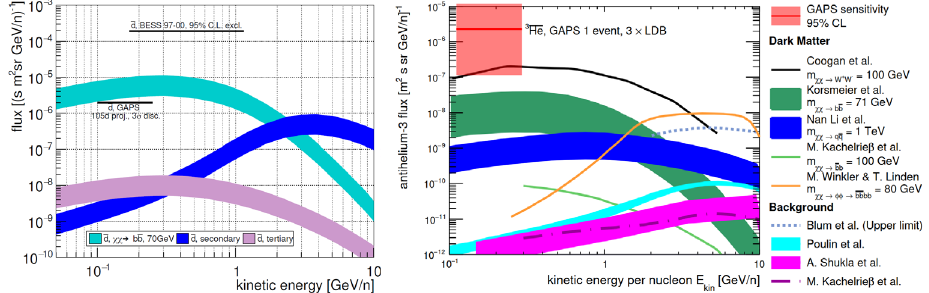
Figure 2. Left panel : the predicted antideuteron flux from a generic 70-GeV WIMP annihilating via b ¯ b -pairs (cyan), as well as the predicted secondary (blue) and tertiary (pink) astrophysical antideuteron flux. The anticipated sensitivity of GAPS [5, 19] for a 3 σ discovery and the BESS 97–00 95% C.L. Figure 1. Left panel : A schematic view of the GAPS detector. Right panel : The GAPS sensitivity for exclusion limits are shown [20]. Right panel : GAPS antihelium sensitivity (red line, with 95% C.L.) cosmic antiproton spectrum (red) at the top of the atmosphere is shown with the statistics expected from compared with the flux predicted by di ff erent dark matter and astrophysical background models three 35-day flights [7]. Data from BESS (1995 and ‘97 [12]), BESS Polar II [13], PAMELA (2006 09 − [14]), and AMS-02 (2011 18 [15, 16]) are also shown. −